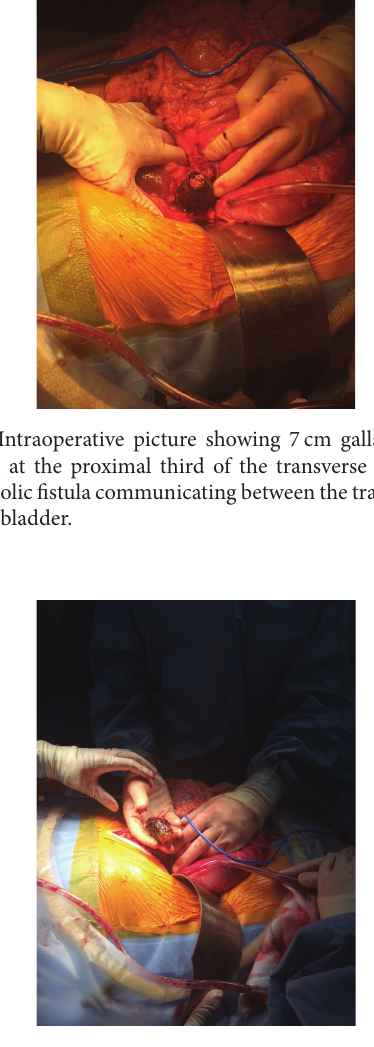
Figure 5: Intraoperative picture showing 7 cm gallstone being removed from the transverse